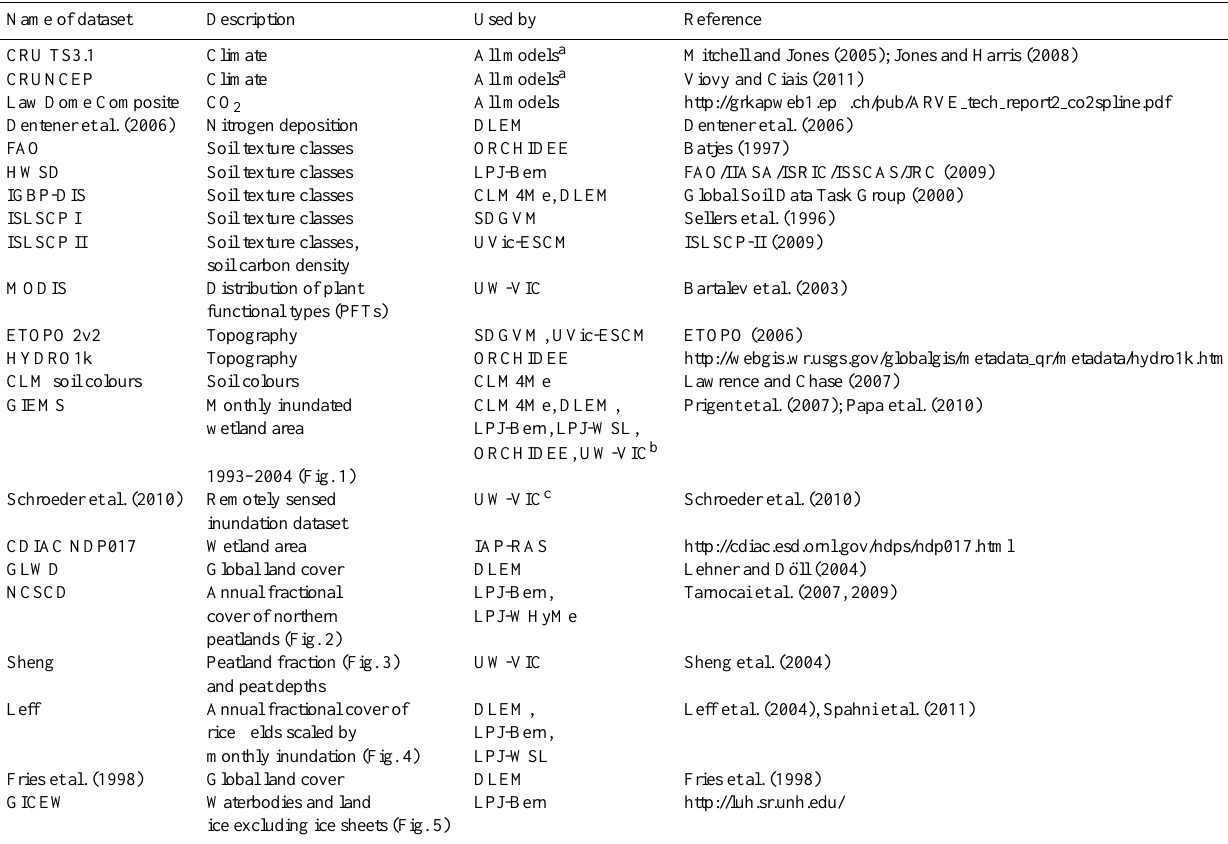
Table 3. Names and types of input datasets together with references and a list of models that used the data.